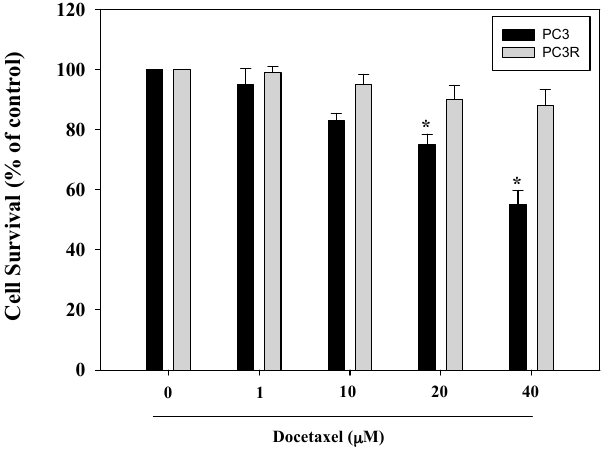
Figure 2. Effects of docetaxel on PC3 and PC3R cell viability at 24 h time point. Data were summarized from three independent experiments. * p < 0.05 vs. docetaxel (0 µ M) group.